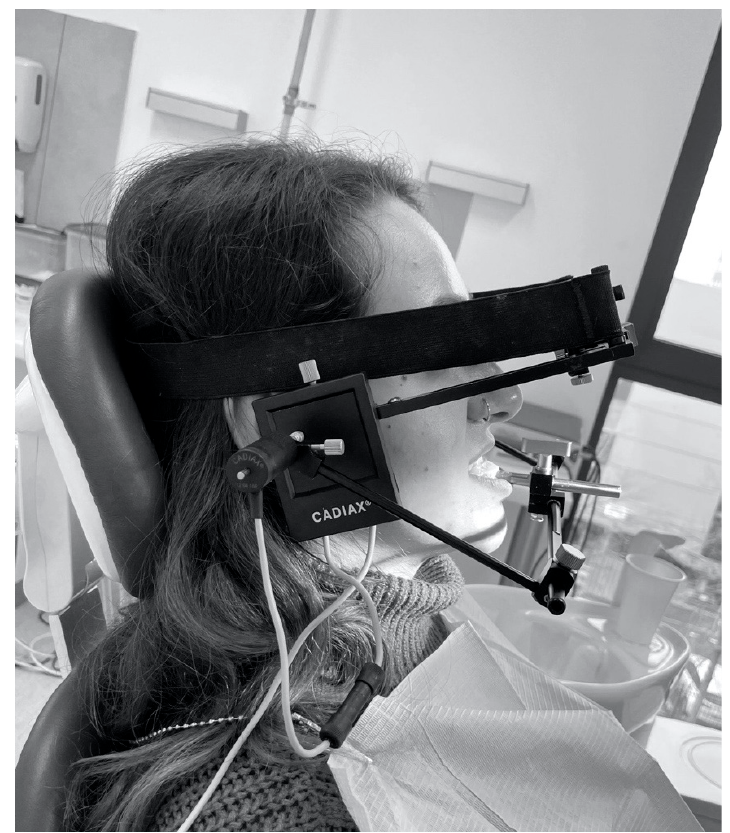
Figure 2. Condylography using the Cadiax Compact—lateral image.